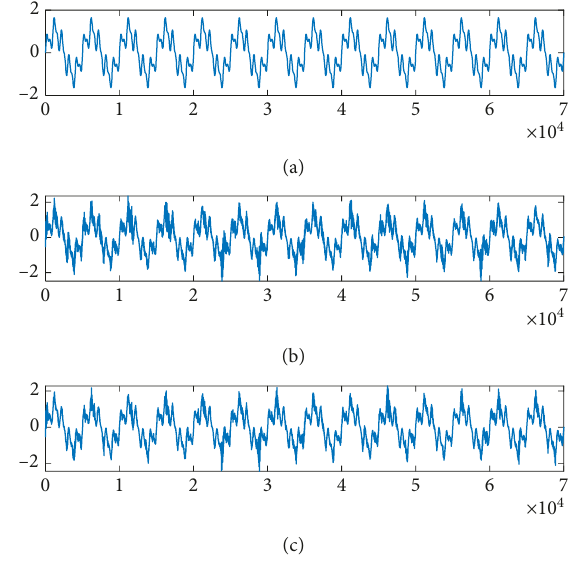
Figure 3: The error signal of the NLMS and the improved LMS